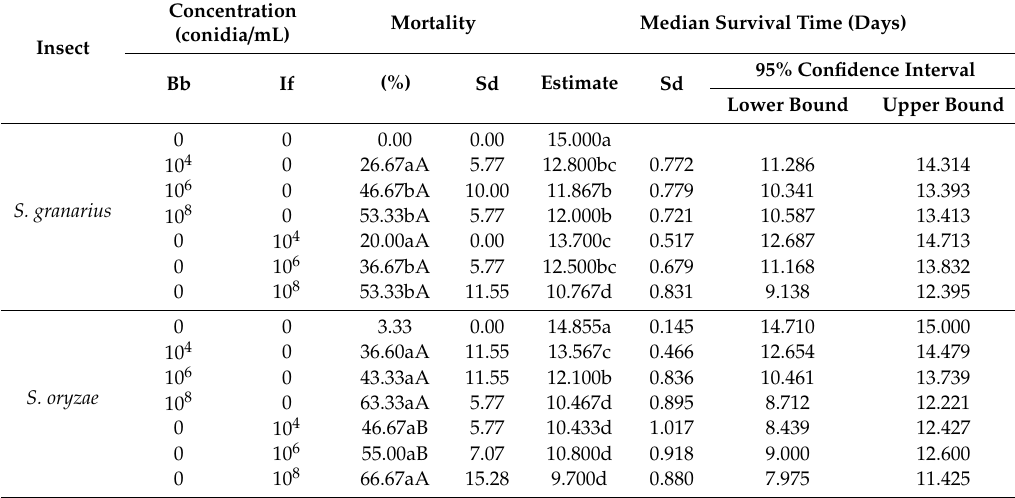
Mean values of di ff erent concentration, within the same insect and pathogen, followed by the same small letter are not significantly di ff erent; Mean values of di ff erent insect, within the same concentration and pathogen, followed by the same capital letter are not significantly di ff erent (Bonferroni test, a = 0.05), Estimate values of median time of the same insect followed by the same small letter are not significantly di ff erent (Kaplan–Meier, a = 0.05), * Median